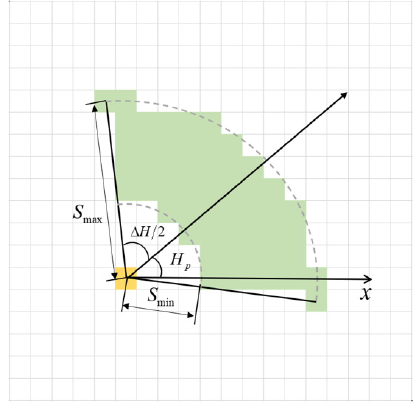
Figure 6. Feasible region constraints.